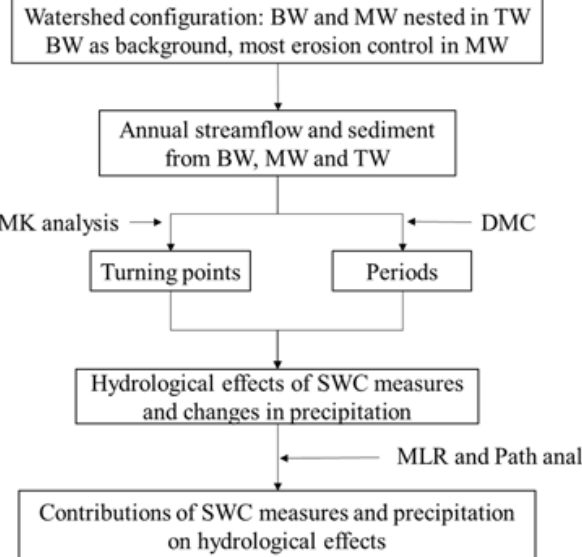
Figure 2. Flowchart of the datasets, watershed, and methodologies utilized in this study.